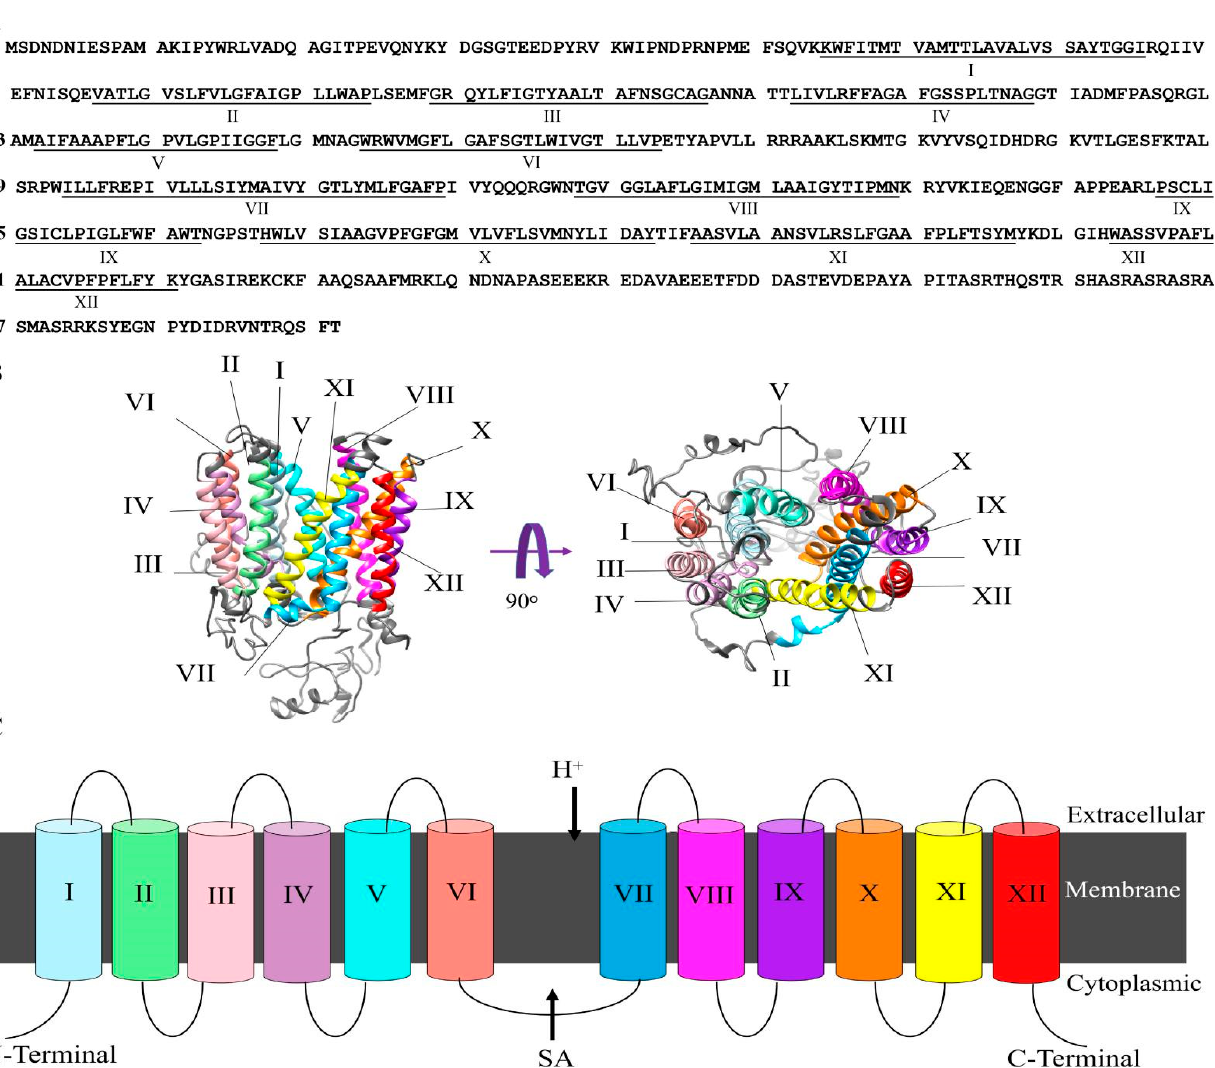
Figure 2. Structure of FgMFS1. ( A ) Deduced amino acid sequence of FgMFS1. The underlined are the 12 transmembrane spanners (TMS; I-XII). ( B ) Predicted tertiary structure of FgMFS1. The 12 TMS are colored from the N-terminus in blue to the C-terminus in red. Consistent with [25], TMS I, IV, VII, and X are in the center of the predicted structure; II, V, VIII, and XI are on the sides; III, VI, IX, and XII are placed on the outside. ( C ) Simplified topology of FgMFS1 in the membrane.